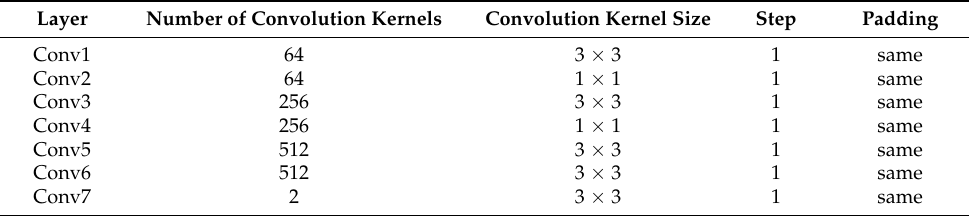
Table 3. Parameters of FCN without pooling